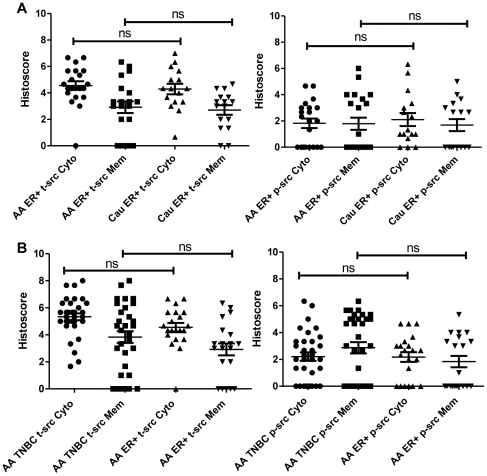
Src expression in African American and Caucasian breast cancer.A) Comparison of total Src (t-src) subcellular localization in the cytoplasm (Cyto) and membrane (Mem) among African American (AA) and Caucasian (Cau) ER+BC cases. B) Comparisons of p-Y416Src (p-Src) localization (cytoplasmic/membrane) among African American (AA) and Caucasians in ER+BC. C) Comparison of total Src subcellular localization (cytoplasmic/membrane) among TNBC and ER+BC in African Americans. D) Comparisons of p-Src subcellular localization (cytoplasmic/membrane) among TNBC and ER+BC in African Americans. Statistical differences in the distribution of total and p-Src kinase were analyzed by the Mann-Whitney U test. ns - not significant. The graphs represent the mean histoscore ± SEM (standard error of mean).